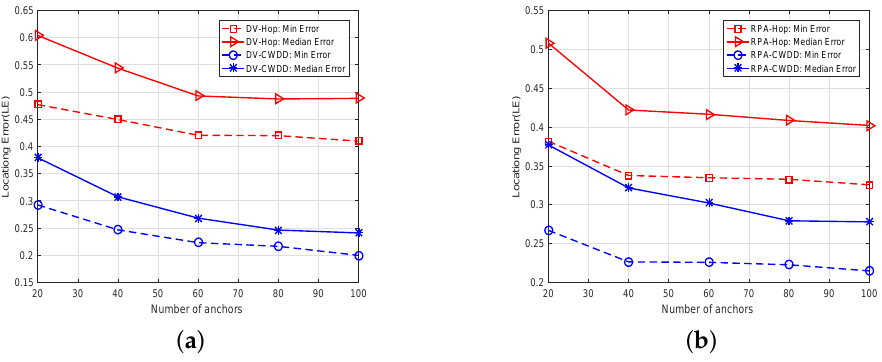
Figure 8. Different numbers of anchors: ( a ) Dv-based, ( b )